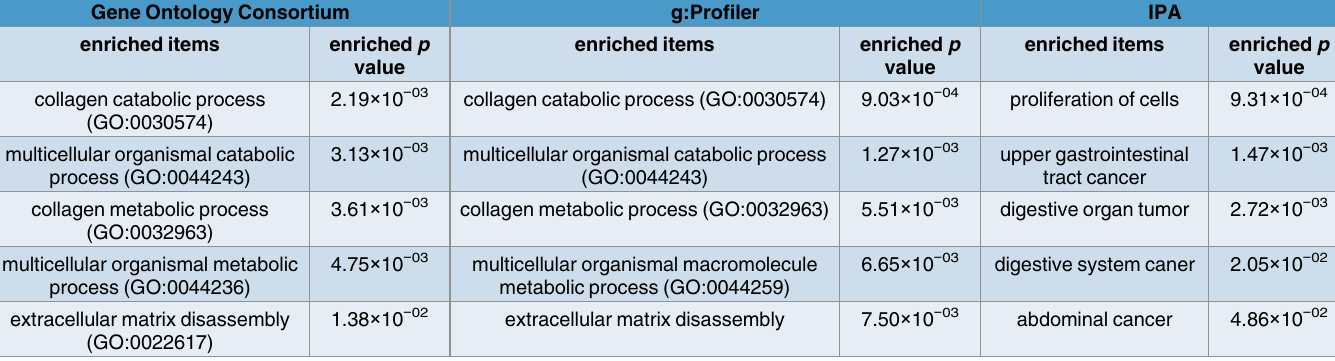
Table 4. The functional enrichment of sDNB genes in at least 50% of samples for